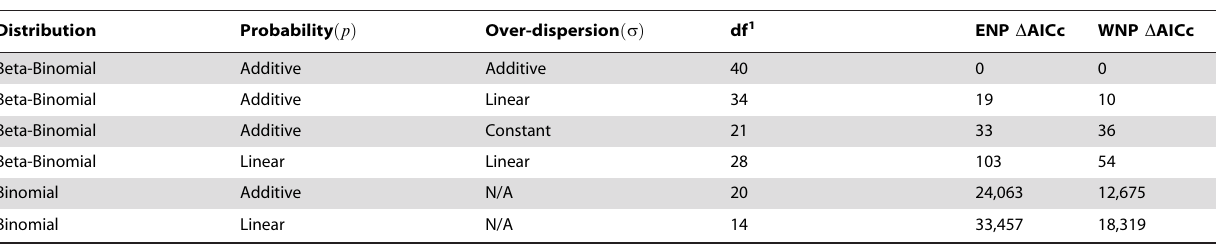
Table 3. Model selection